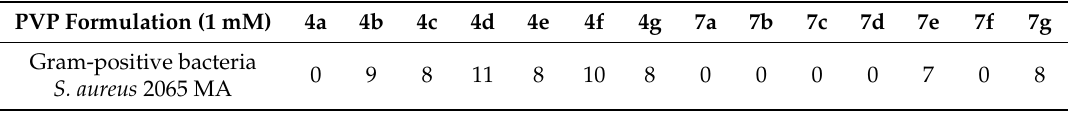
Table 2. Growth inhibition halo diameters (mm) for the polyvinylpyrrolidone (PVP)-arylthio/ cyclohexylthio-lapachones 4a – g and PVP-sulfonyl-lapachones 7a – g (1 mM concentration of each lapachone derivative) against Staphylococcus aureus .